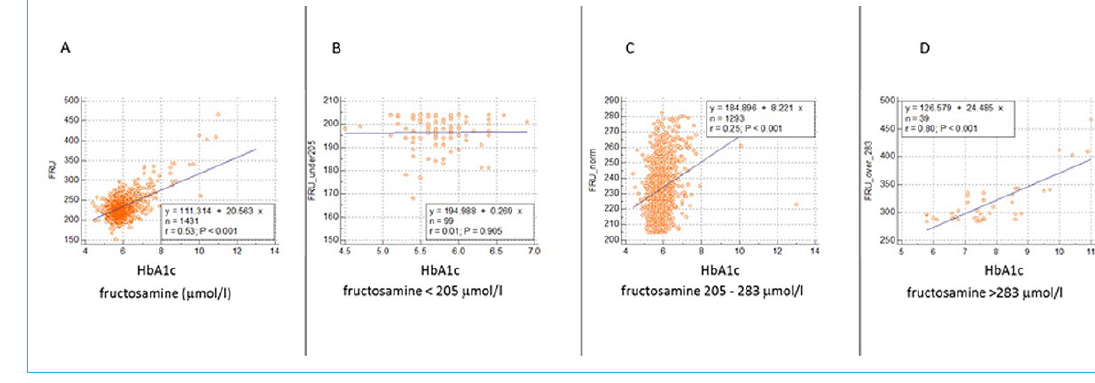
Figure 5: Relationship between fructosamine and HbA1c.This 4-panel figure compares glycated haemoglobin A1c and fructosamine levels in three different fructosamine concentration ranges (data from 1431 participants). A all participants. B subjects with fructosamine concentrations <205 μmol/l. The glycated haemoglobin A1c values range from 4.5% to 7.0%. C Participants exhibiting fructosamine values within the refer- ence interval. Glycated haemoglobin A1c values are within a narrow window. D individuals with high fructosamine levels have glycated haemoglobin A1c values between 5.8% and